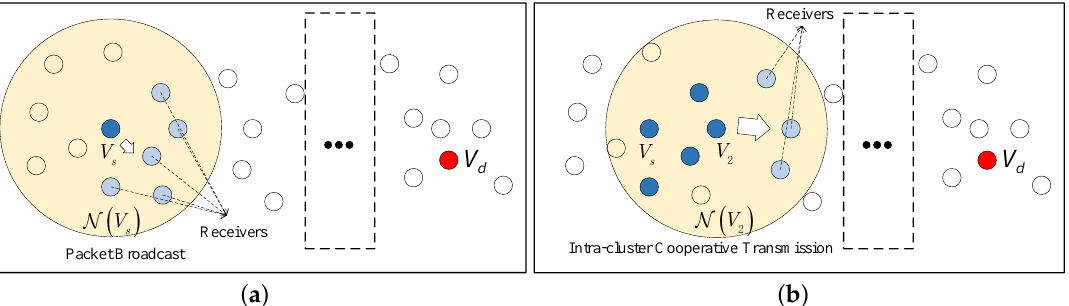
Figure 1. The cluster-based opportunistic cooperative routing. ( a ) Broadcast of source node V s ( b ) Intra-cluster cooperative